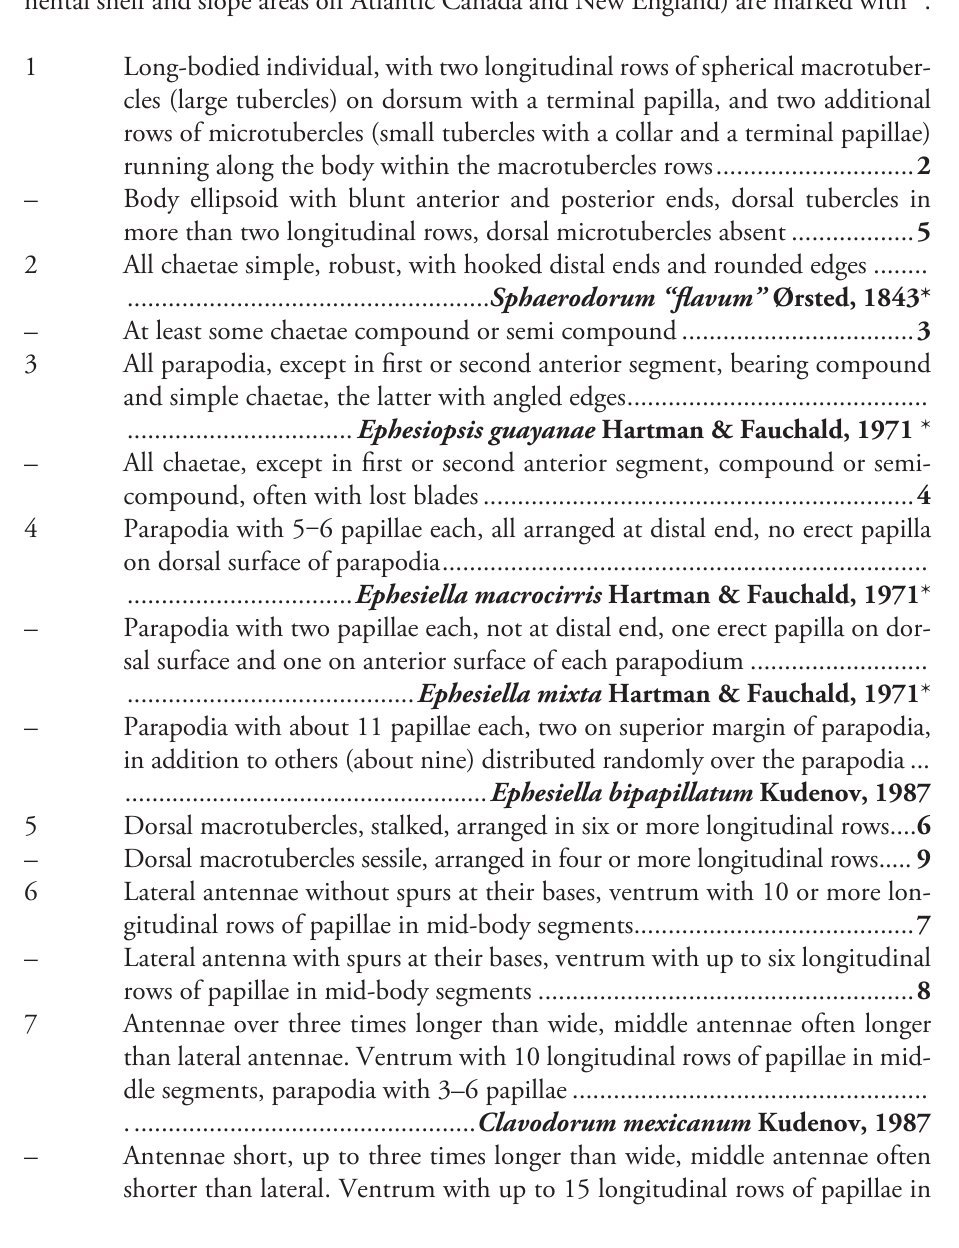
1 Long-bodied individual, with two longitudinal rows of spherical macrotuber- cles (large tubercles) on dorsum with a terminal papilla, and two additional rows of microtubercles (small tubercles with a collar and a terminal papillae) running along the body within the macrotubercles rows ............................. 2 – Body ellipsoid with blunt anterior and posterior ends, dorsal tubercles in